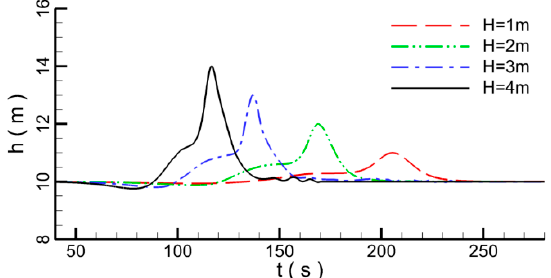
Figure 20. Time series of the tsunami-like wave profile recorded at sensor L 1 .